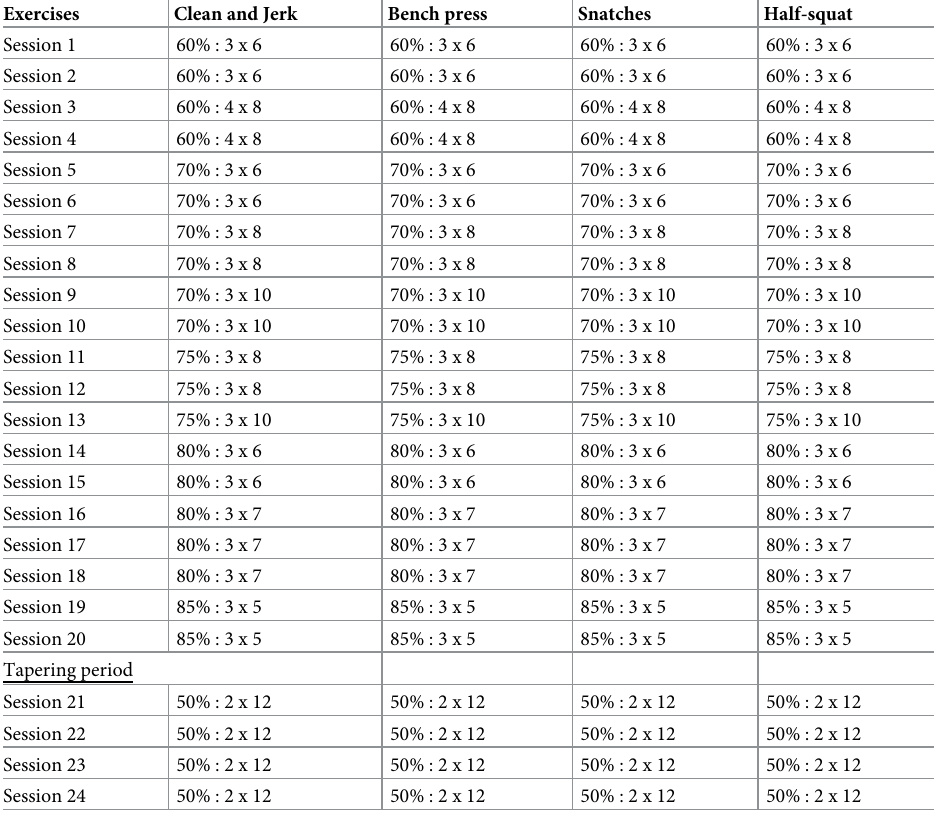
Table 1. Weight-lifting training program and tapering period as followed over 12